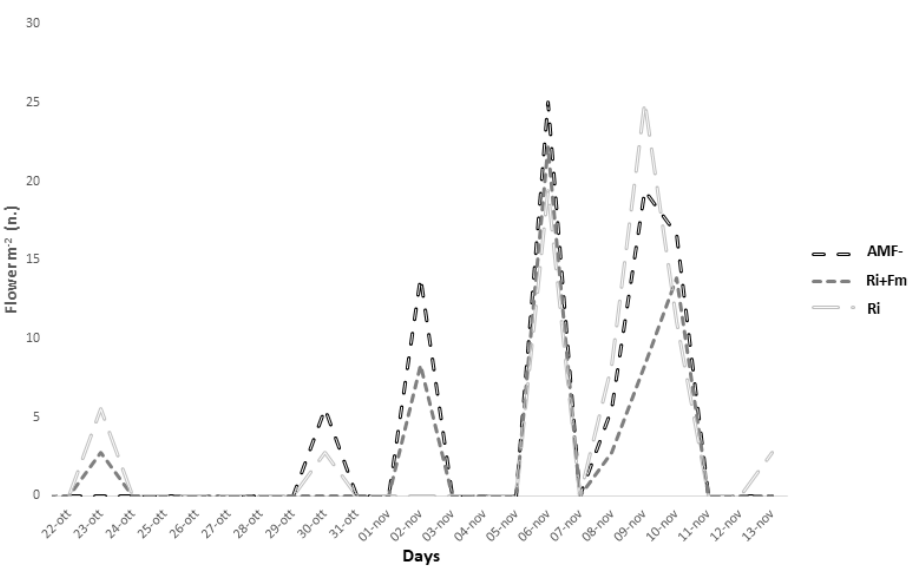
Figure 3. Effects of AMF inoculum composed of Rhizophagus intraradices alone (Ri), R. intraradices and Funneliformis mosseae (Ri + Fm) or the control (AMF-) on the flowering calendar of Crocus sativus corms and the daily number of picked flowers m − 2 during soilless cultivation.